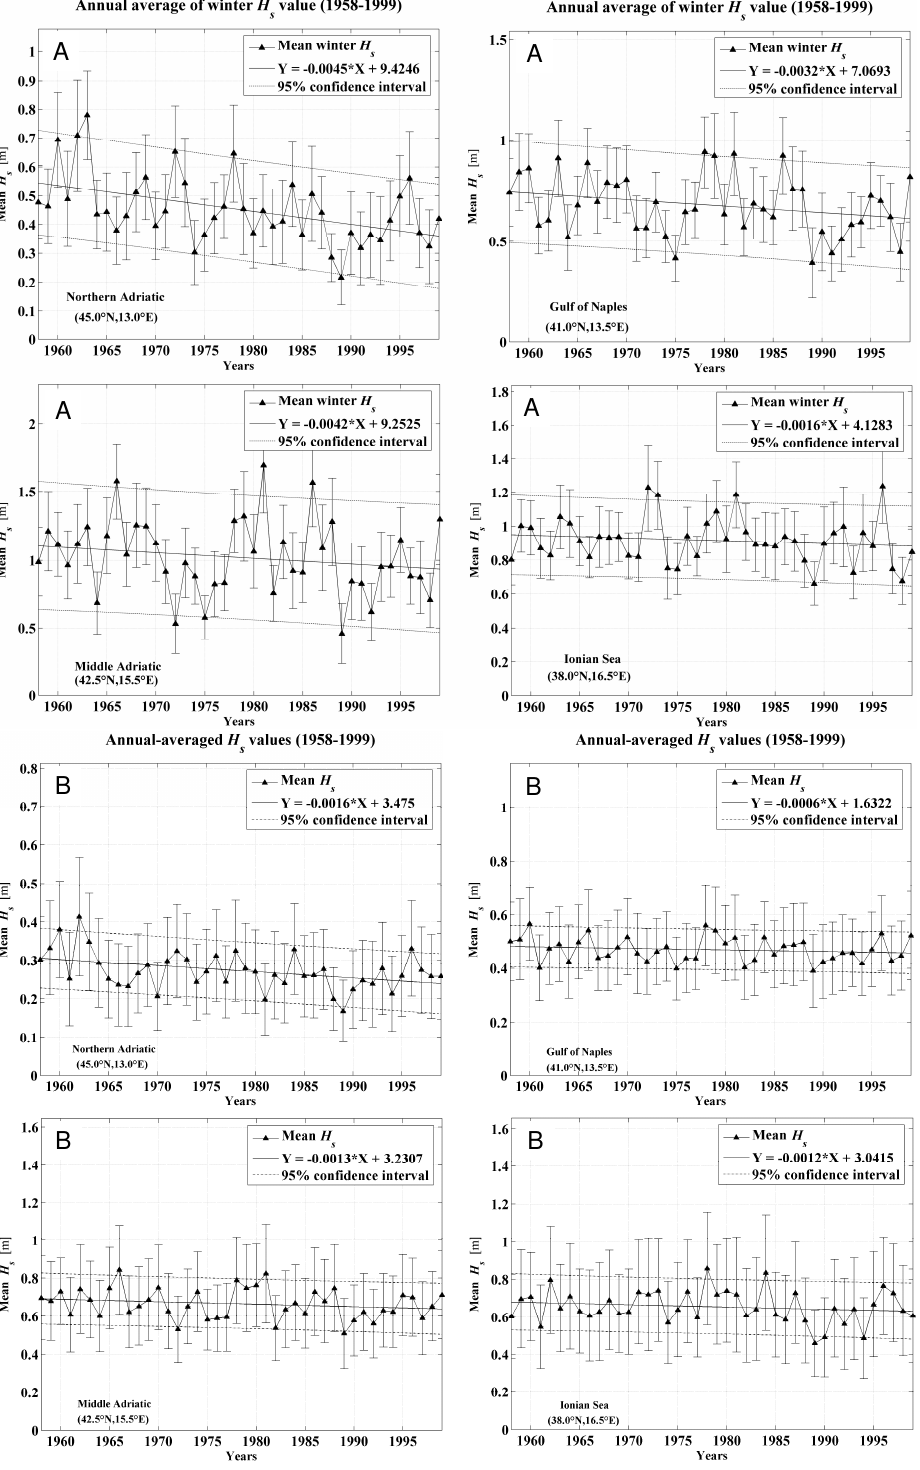
Fig. 3. (A) From (a) – (d) , at four different geographical sites, the winter-averaged H s values through the 1958–1999. The strait solid line represents the linear regression of the timeseries with 95%-confidence intervals (dashed dotted-line). Error bars on y -values have amplitude equal to two times the H s standard deviations. The four trends are statistically significant at the 5%-level of a Student’s t . (B) From (a) – (d) , at the same geographical sites as (A), the annual-averaged H s values through 1958–1999. The strait solid line represents the linear regression of the timeseries with 95%-confidence intervals (dashed dotted-line). Error bars on y -values have amplitude equal to two times the H s standard deviations. The four trends are statistically significant at the 5%-level of a Student’s t